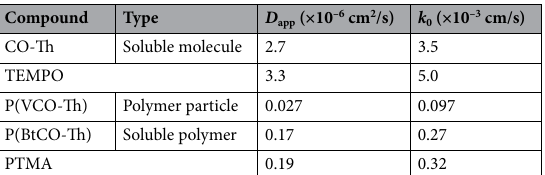
Table 2. Electrochemical kinetic parameters for the thianthrene and TEMPO derivatives estimated by RDE.